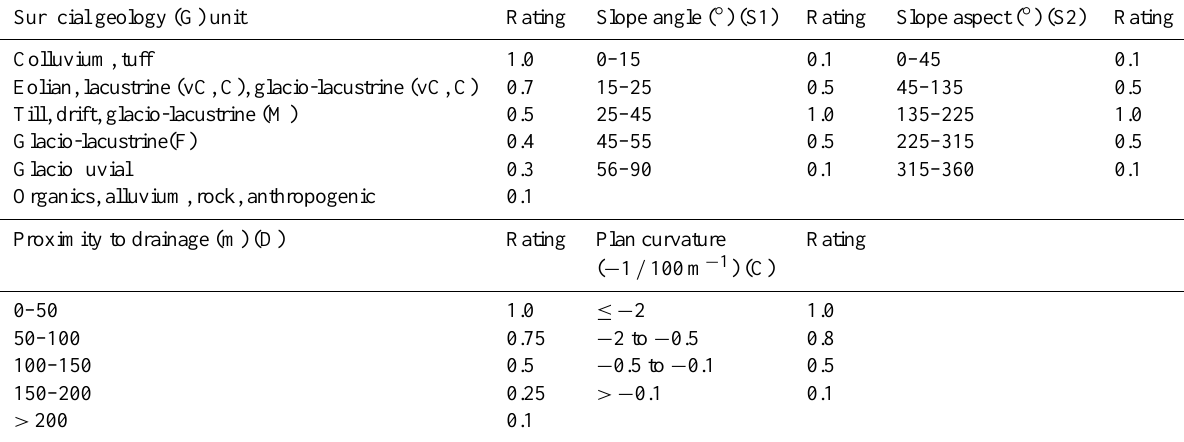
Table 1. Debris flow parameters and class